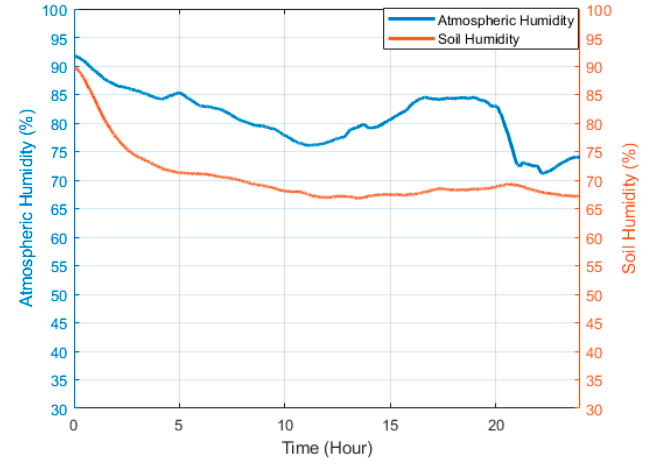
Figure 11. Atmospheric and soil humidity (%) evolution over time—Experimental test